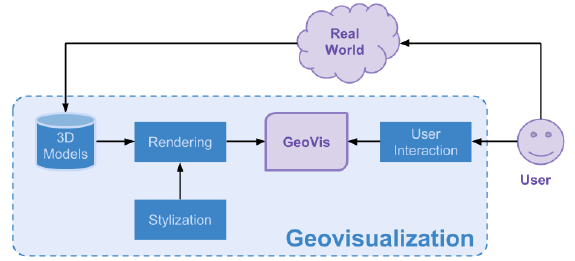
Figure 1. Geovisualization pipeline: from 3D modeling to user